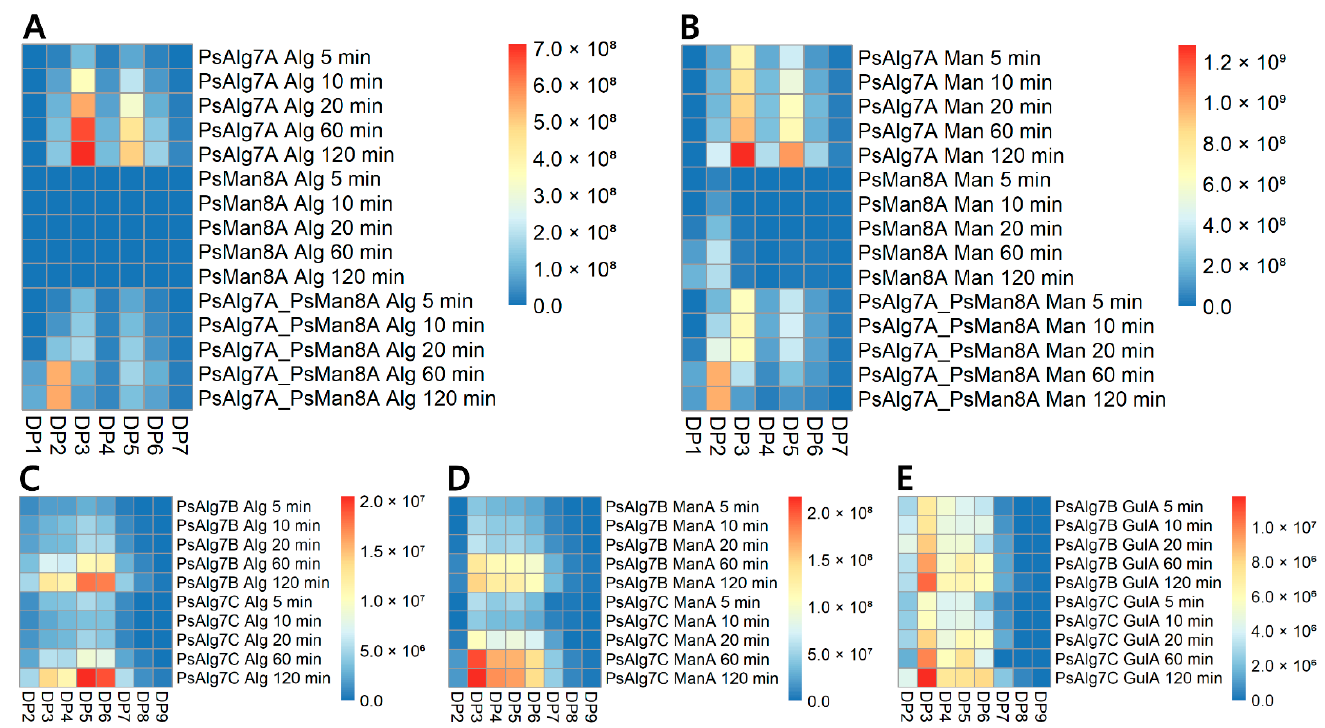
Figure 6. Heat maps of averaged relative intensities derived from the LC-ESI-MS analysis of time-course experiments for the alginate lyases: ( A ) PsAlg7A and PsMan8A acting on alginate alone and in synergy; ( B ) PsAlg7A and PsMan8A on polyM alone and in synergy; ( C ) PsAlg7B and PsAlg7C on alginate; ( D ) PsAlg7B and PsAlg7C on polyM; ( E ) PsAlg7B and PsAlg7C on polyG. Barchart representations of the data including the standard errors from triplicate experiments can be found in the Supplementary Materials, Figure S4. Example chromatograms from PsAlg7A and PsMan8A on polyM with thorough descriptions can be found in the Supplementary Materials, Figures S5–S8.